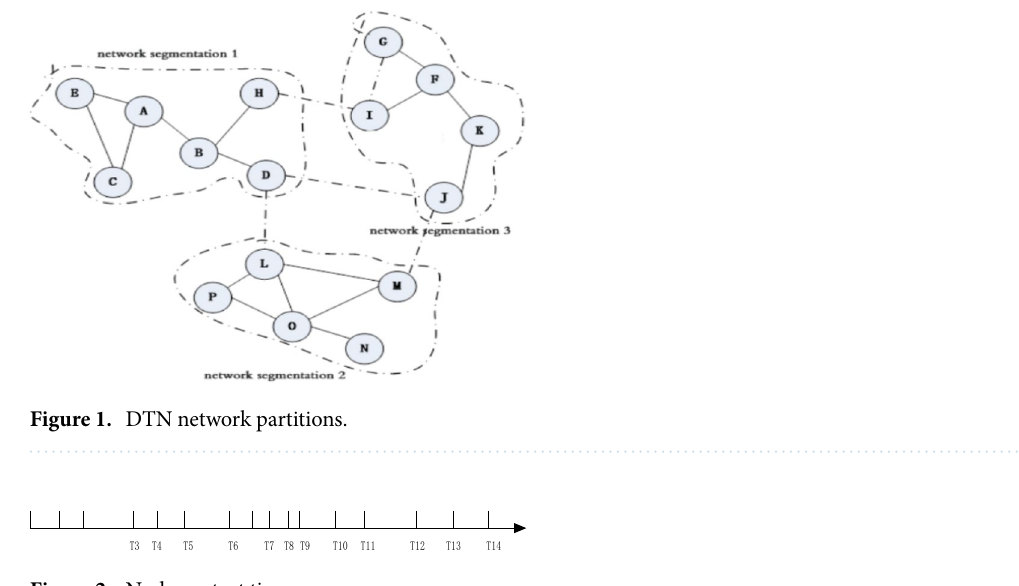
Figure 2. Node contact